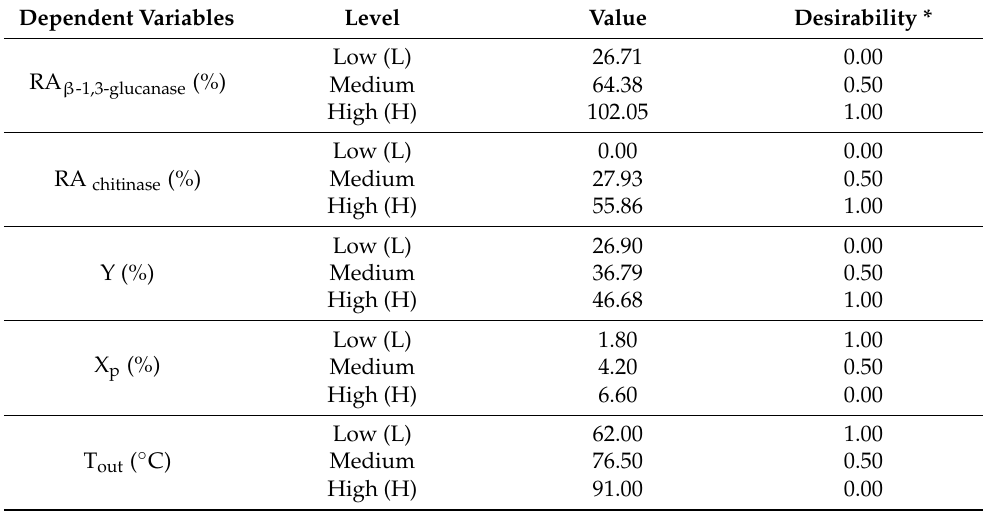
Table 6. Desirability values selected for the dependent variables (responses) of the spray drying of enzyme